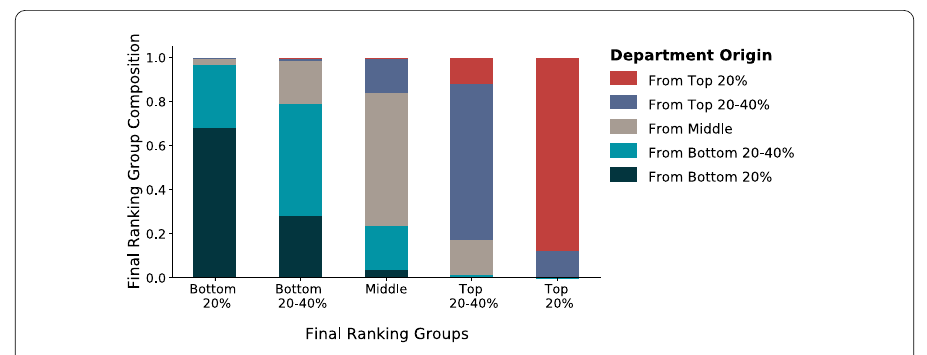
Figure S10 Final ranking group composition of Computer Science departments. Rank mobility results derived from the best fitting Faculty production model with egalitarian initialization, with β = 1.0 and p = 0.02. The composition of departments’ origin is traced and averaged over 50 hiring simulated networks